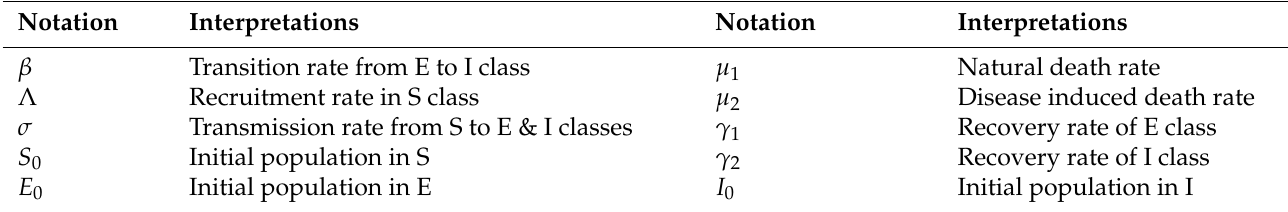
Table A1. Model parameters and their descriptions.